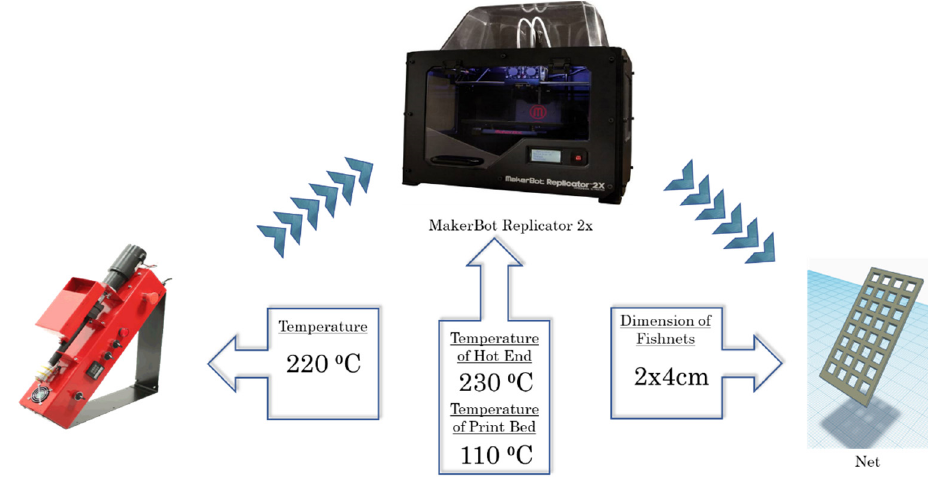
Figure 1. The used printing system and the growth conditions.